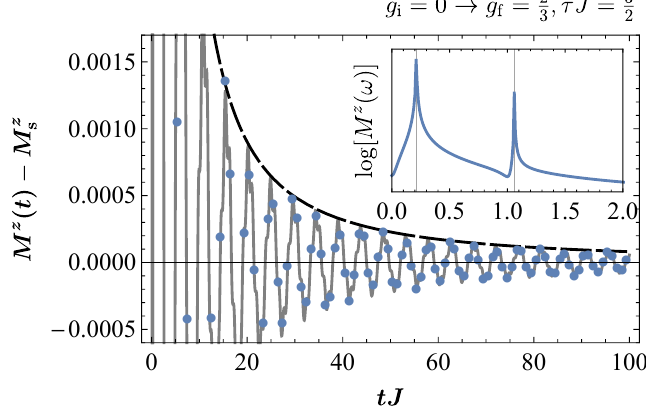
Figure 5: Stationary part of the transverse magnetisation as a function of the quench duration for several quench protocols. The dashed black and full grey lines show the adiabatic and sudden values respectively. The insets show large τ behaviour, where the adiabatic value is = lim z defined by M z . τ →∞ M a s